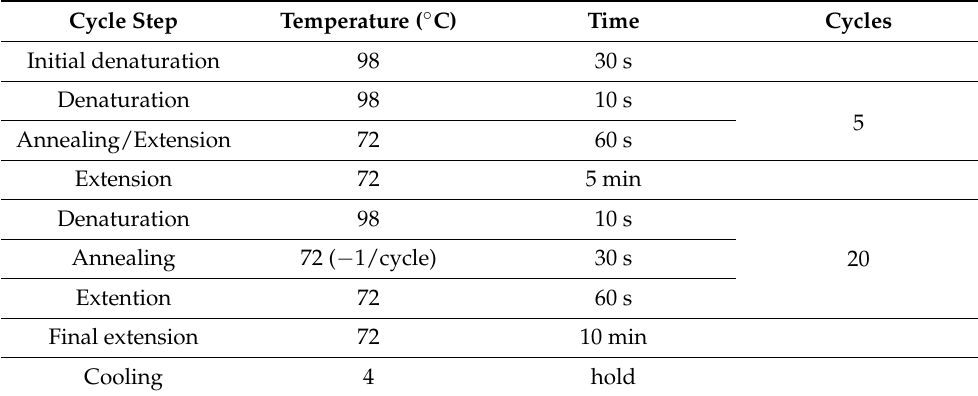
Table 7. Combined 2-step and 3-step touch-down PCR